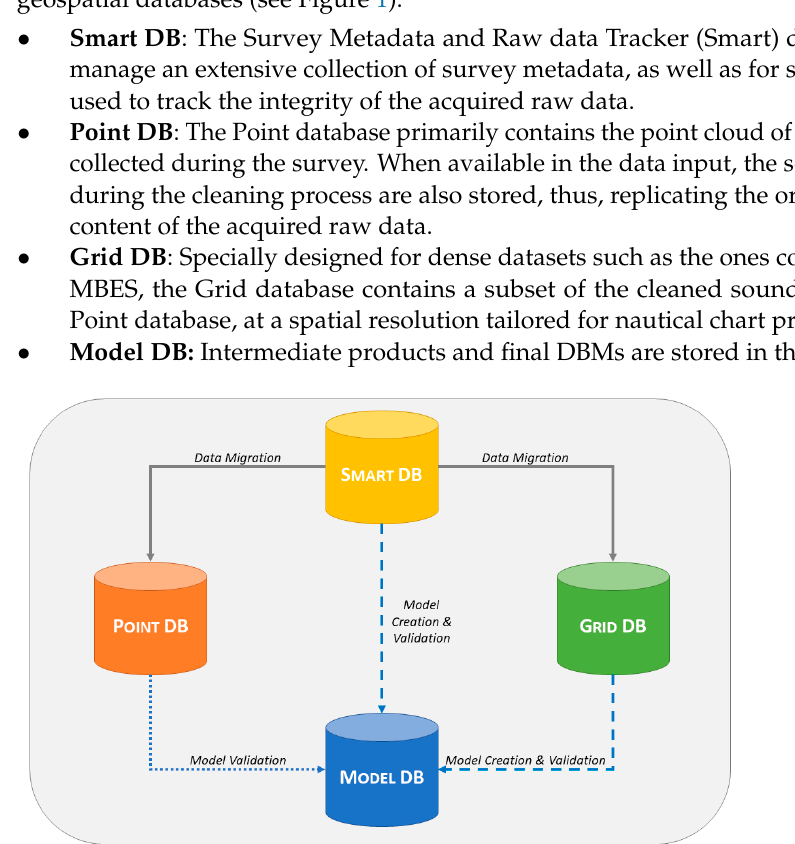
Figure 1. The four types of DYBDB databases (Smart DB, Point DB, Grid DB, and Model DB) and their interactions during key processes. The ‘data migration’ process (connectors shown in full grey) upload soundings to both Point DB and Grid DB based on the information stored on the Smart DB. The ‘model creation’ process (in dashed blue) combines soundings stored in Grid DB by retrieving the metadata information from the Smart DB. Once created, the ‘model validation’ (in dotted and dashed blue) is a semi-automated process that may require access to the point cloud of soundings at full resolution (shown in dotted